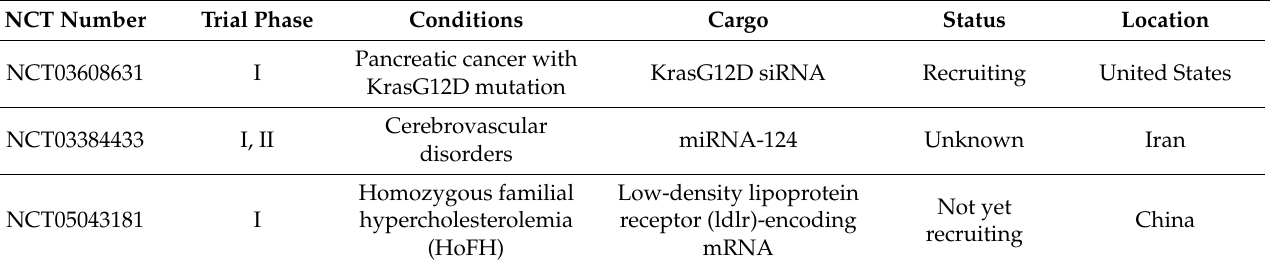
Table 1. Clinical trials of EVs aimed at tNA